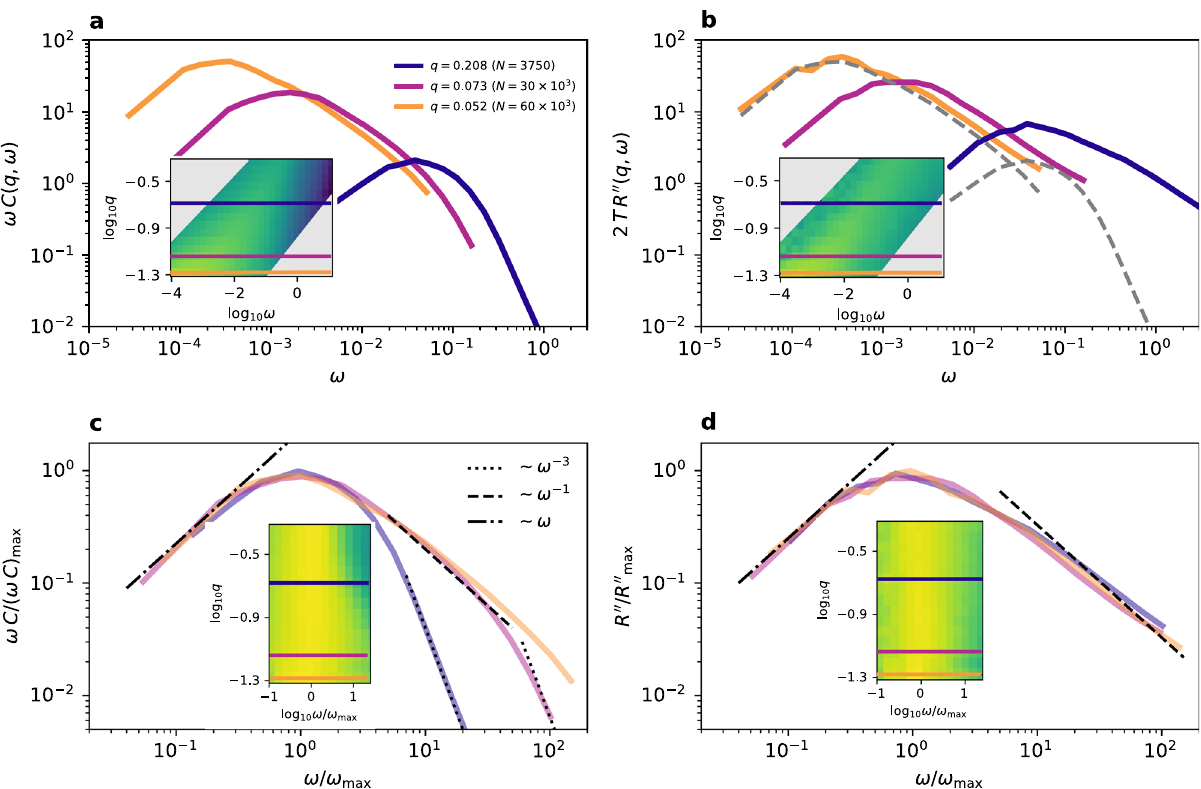
Fig. 2 Correlation and response in the critical active system. a Frequency-resolved correlation functions at various q -s (colored curves). Simulating larger systems gives access to lower wave-vectors (see legend). The inset shows ln ½ ω C ð q ; ω Þ(cid:5) as color map (value increasing from blue to yellow) at all q and ω -s. The gray area represents the highest and lowest ω measured at each q determined by the simulation duration and sampling frequency. The horizontal lines indicate the q -values selected for the main panel. b Frequency-resolved response function evaluated by the fi eld-free method at the same q -s as in a (colored curves, same legend as in a ). The correlation spectra for the highest and lowest wave-vectors in a are reproduced here as dashed lines to show that the deviation between response and correlation is more pronounced at high q . The inset is the same of the inset of a for ln ½ R 00 ð q ; ω (cid:5)Þ . c Frequency- resolved correlation functions from a revealing an evident deviation from scaling in the high- q /high- ω regime. The asymptotic behaviors of these functions are highlighted by power-law fi ts (straight lines, see legend). The inset is the same of the inset of a for ln ½ ω C = ð ω C Þ max (cid:5) . d Scaled response functions from b . Differently from c , a good data-collapse is observed for the response function. The asymptotic behaviors are evidenced by power law fi ts (straight lines, (cid:5) same legend as in c ). The inset is the same of the inset of ( a ) for ln ½ R 00 = R 00 max